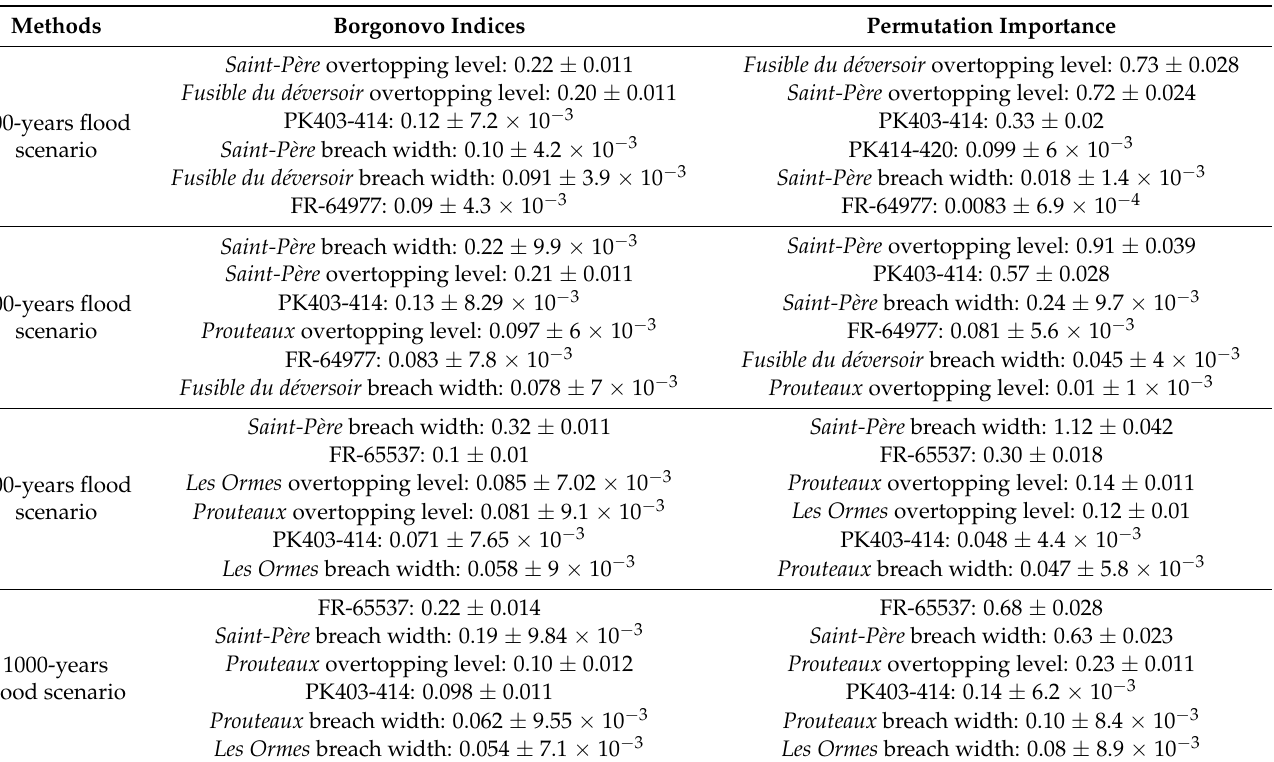
Table 4. Sensitivity analysis at Les Places control point for 100, 200, 500 and 1000-year return period flood events: Borgonovo indices and permutation feature importance with their corresponding asymptotic confidence intervals, typically with a confidence level of 90%. PK and FR indicates, respectively, the friction coefficients for the riverbed and the floodplain (as reported in Figure